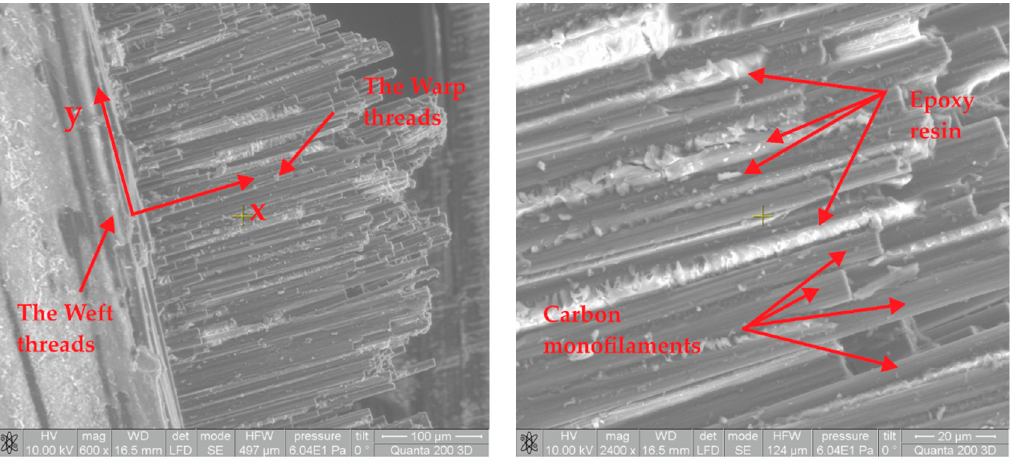
Figure 5. Microstructure analyses of CFRP samples subjected buy tensile test.